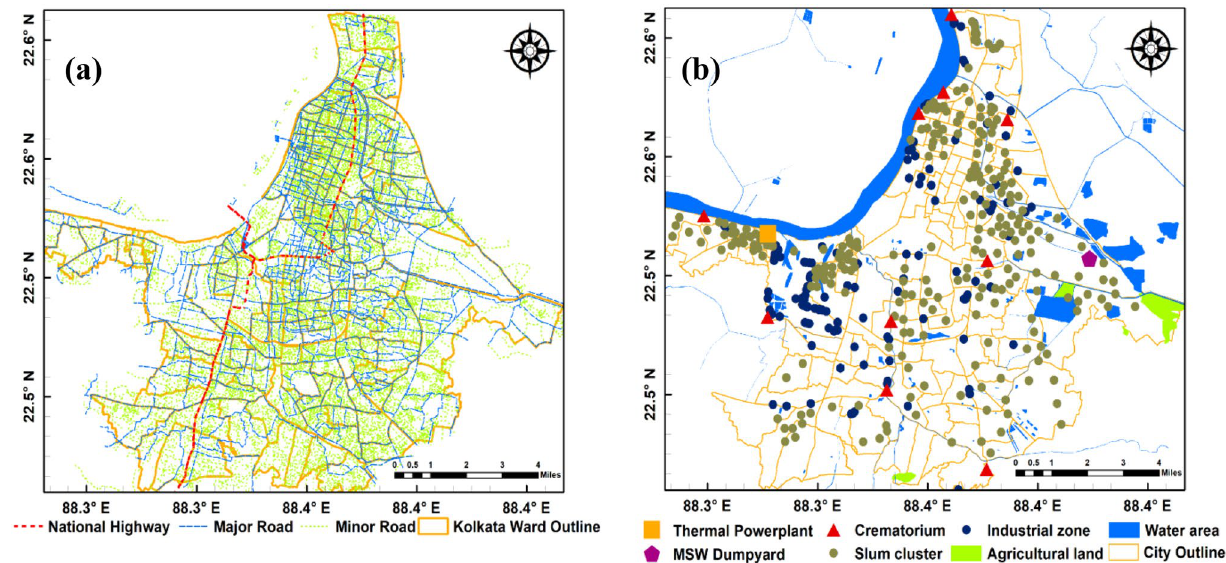
Fig. 2 a Road network in Kolkata and b Spatial location of various types of emission